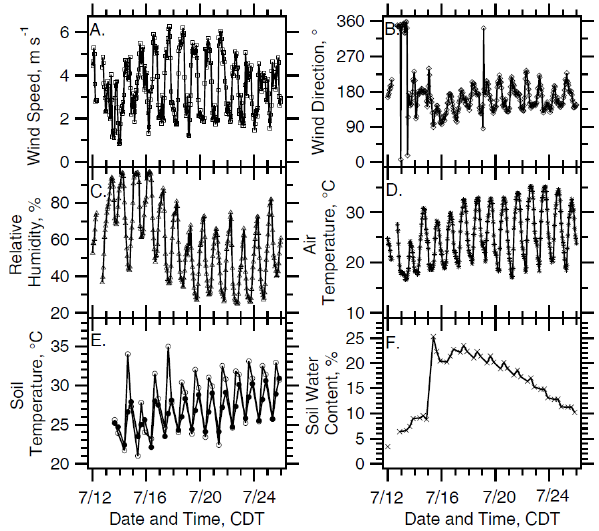
Fig. 2. Hourly averaged meteorological data including wind speed, wind direction, relative humidity, air temperature, soil temperature at a depth of 5cm (open circles) and 25cm (solid circles), and soil water content at a depth of 25cm are shown in Panel (A–F) , respec- tively (Adapted from Hiranuma et al.,